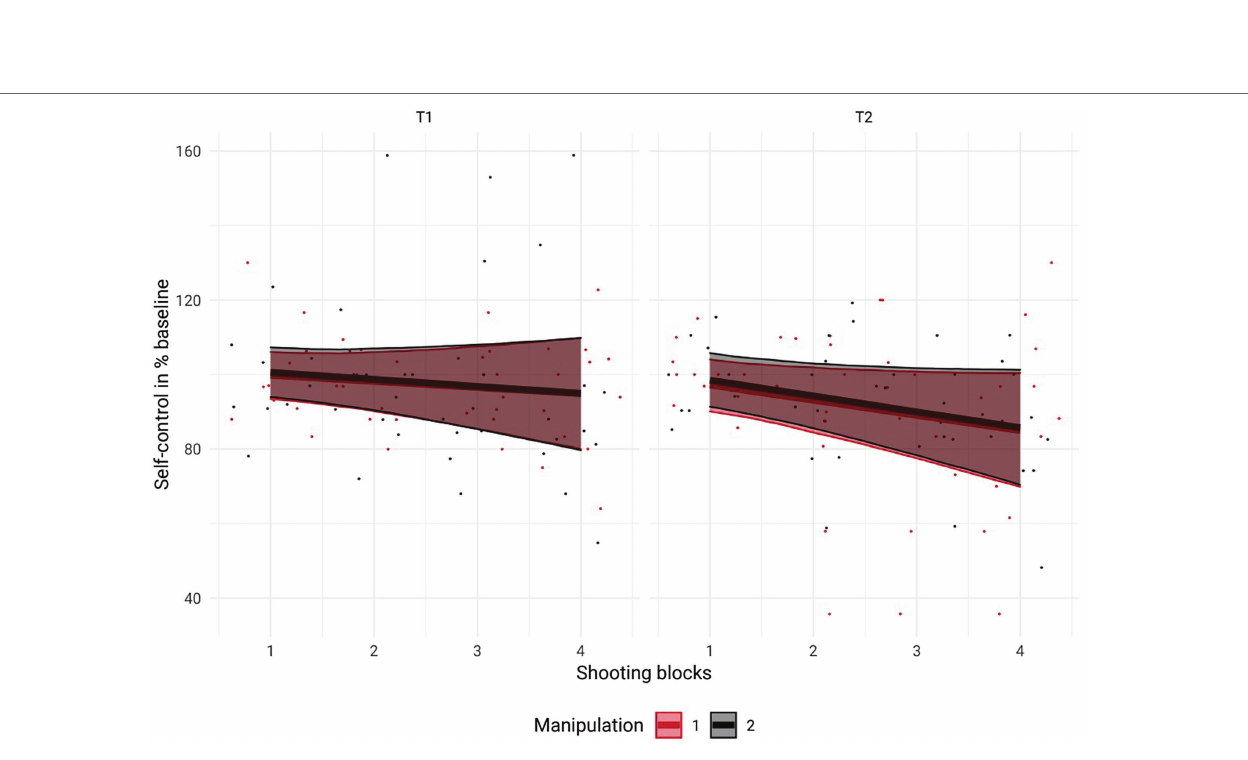
FIGURE 3 | Visualization of perceived self-control strength relative to perceived self-control strength at baseline before (T1) and after (T2) the experimental manipulation as a function of experimental condition. Perceived self-control strength was not affected by prior mental exertion. Data from the experimental group are depicted in red, and data from the control group are depicted in black. Error bars represent 95% credible